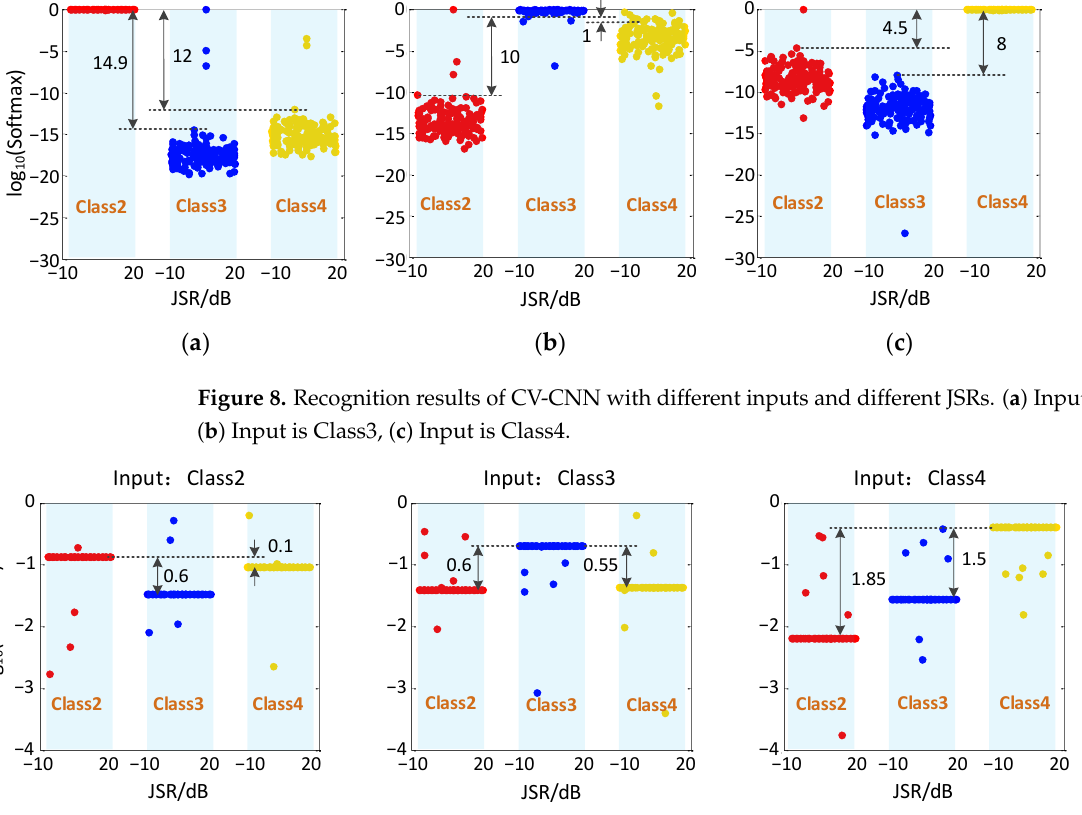
Figure 8. Recognition results of CV-CNN with different inputs and different JSRs. ( a ) Input is